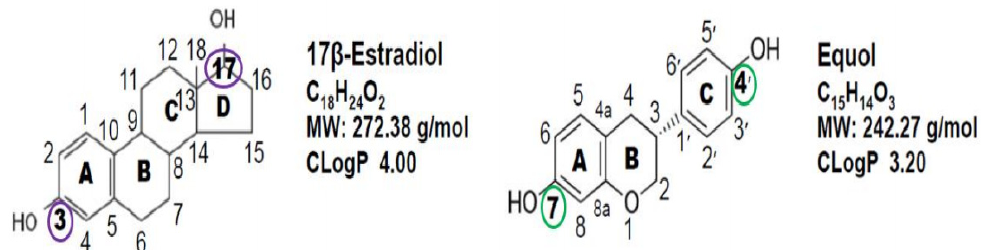
Figure 1. Comparison of the chemical structures, molecular formulas, molecular weights and CLogP values between 17 β -Estradiol and equol. CLogP = the logP value of a compound representing its partition coefficient and lipophilicity. The purple circles at carbon 3 and 17 for 17 β -estradiol represent the functional positions, and the green circles at carbon 7 and 4’ represent the functional position for equol. The equol structure shown above may represent, S-equol, racemic equol or R-equol. Reproduced with permission from MDPI Journals— Int. J. Mol. Sci. [5].